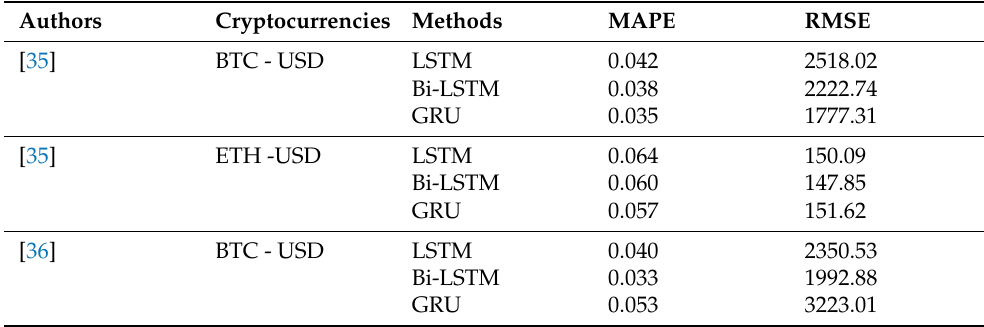
Table 3. Relative comparison with similar